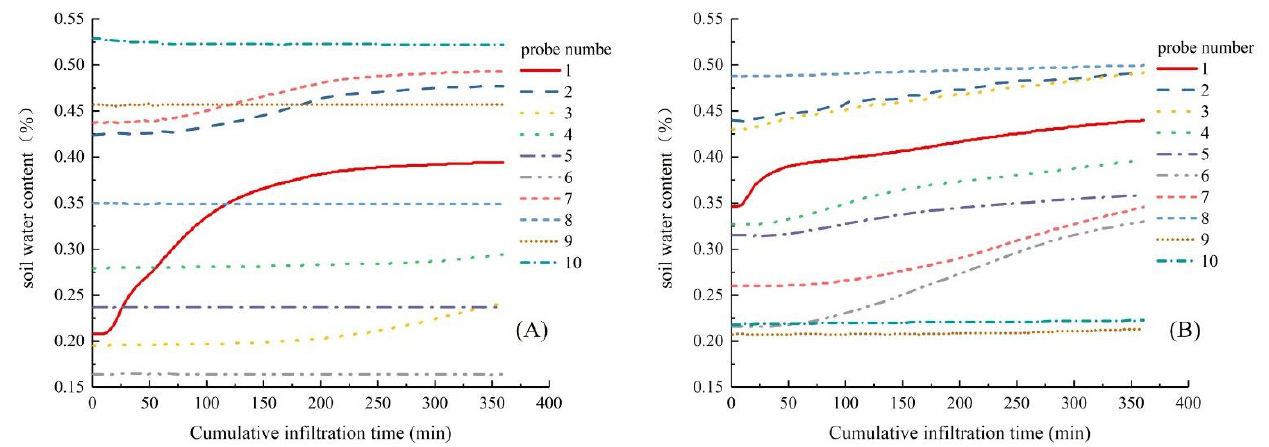
Figure 7. Dynamic change of soil water content. ( A ) is the change of water content of each probe with time in the first siltation dense layer infiltration test, ( B ) is the change of water content of each probe with time in the second siltation dense layer infiltration test.